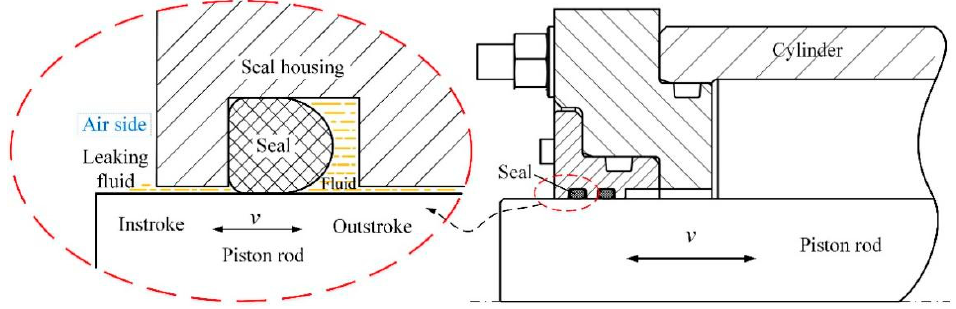
Figure 1. Schematic diagram of the piston rod sealing system.